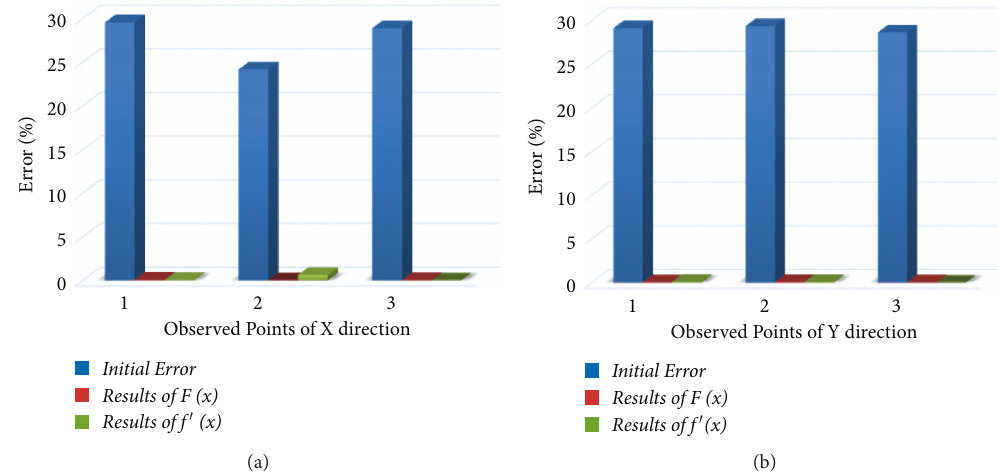
Figure 10: Error comparison of observed points before and after model updating: (a) Error comparison at X direction of the observed points; (b) Error comparison at Y direction of the observed